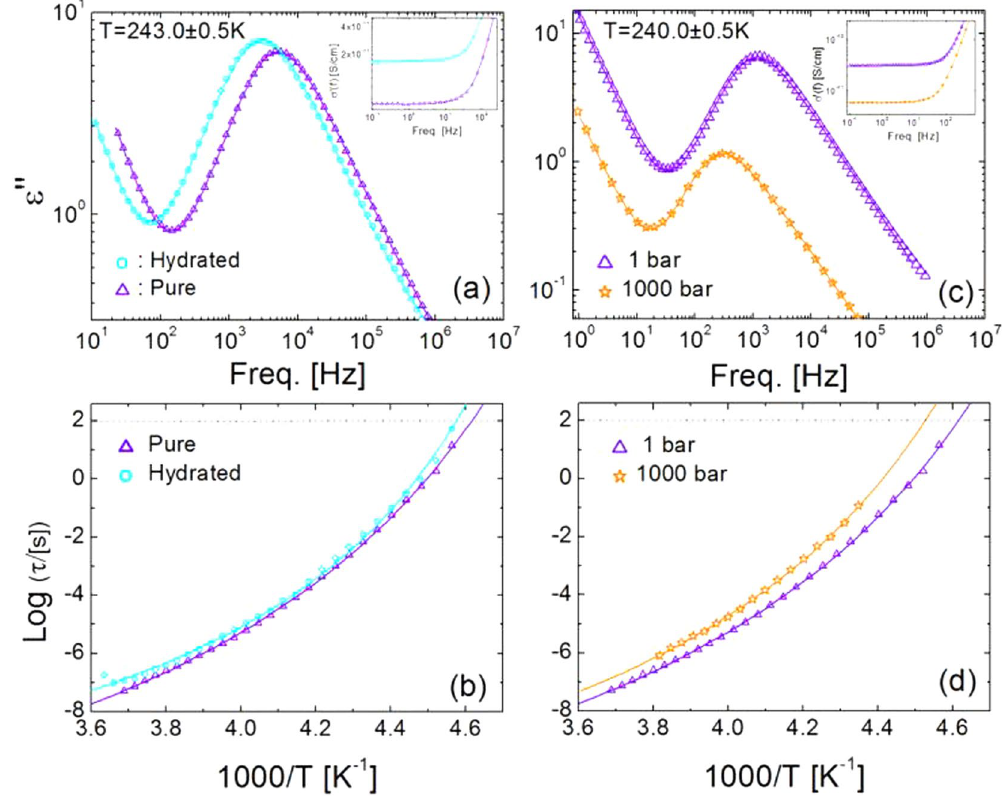
Figure 2. Effect of water and pressure on the temperature-dependent relaxation dynamics of prilocaine. ( a , c ) Comparison of the ambient-pressure dielectric loss spectra of hydrated and pure prilocaine at 243 K ( a ), and of the dielectric loss spectra at 240.5 K of pure prilocaine at ambient (1 bar) and high (1000 bar) pressure ( c ). Continuous lines are fits. Insets: same data in ac conductivity representation. ( b , d ) Arrhenius plot of the primary relaxation times τ of pure and hydrated prilocaine ( b ) at ambient pressure, and of pure prilocaine at 1000 bar ( d ). Continuous lines are fits with the Vogel-Fulcher-Tammann Eq.